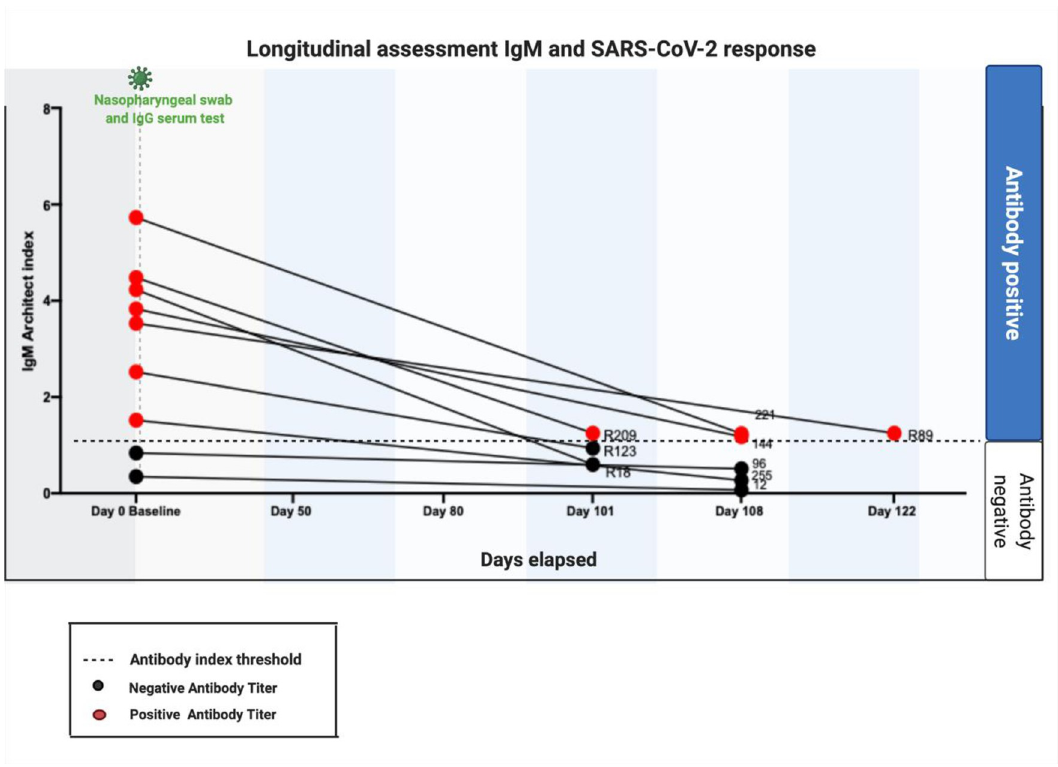
Fig 2. Longitudinal assessment of anti-SARS-CoV-2 IgM and IgG in pregnancy and the puerperium. IgM Baseline and Follow up results. Four women (4/9, 44%) remained IgM positive when tested for anti-SARS-CoV-2 on follow up. (Fig 2). One woman was IgM positive only at baseline testing. Her follow up IgM antibodies